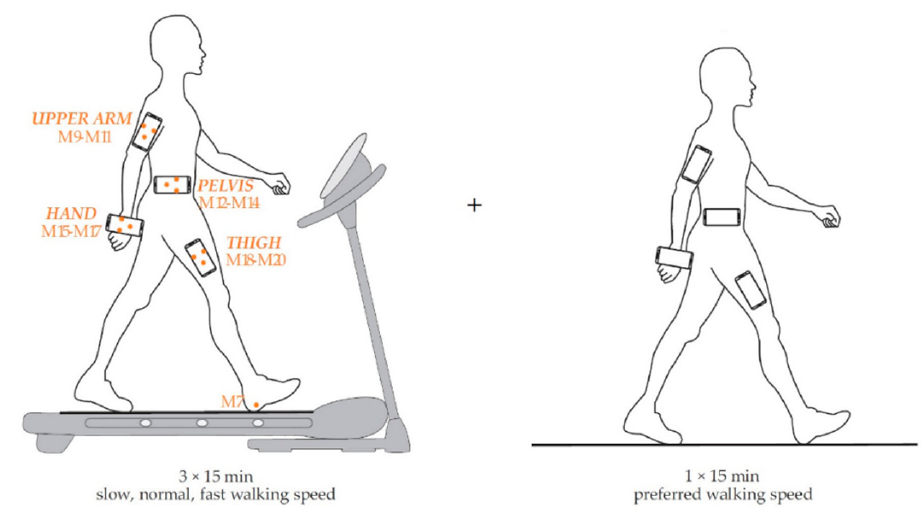
Figure 2. Performance evaluation of the model [57].